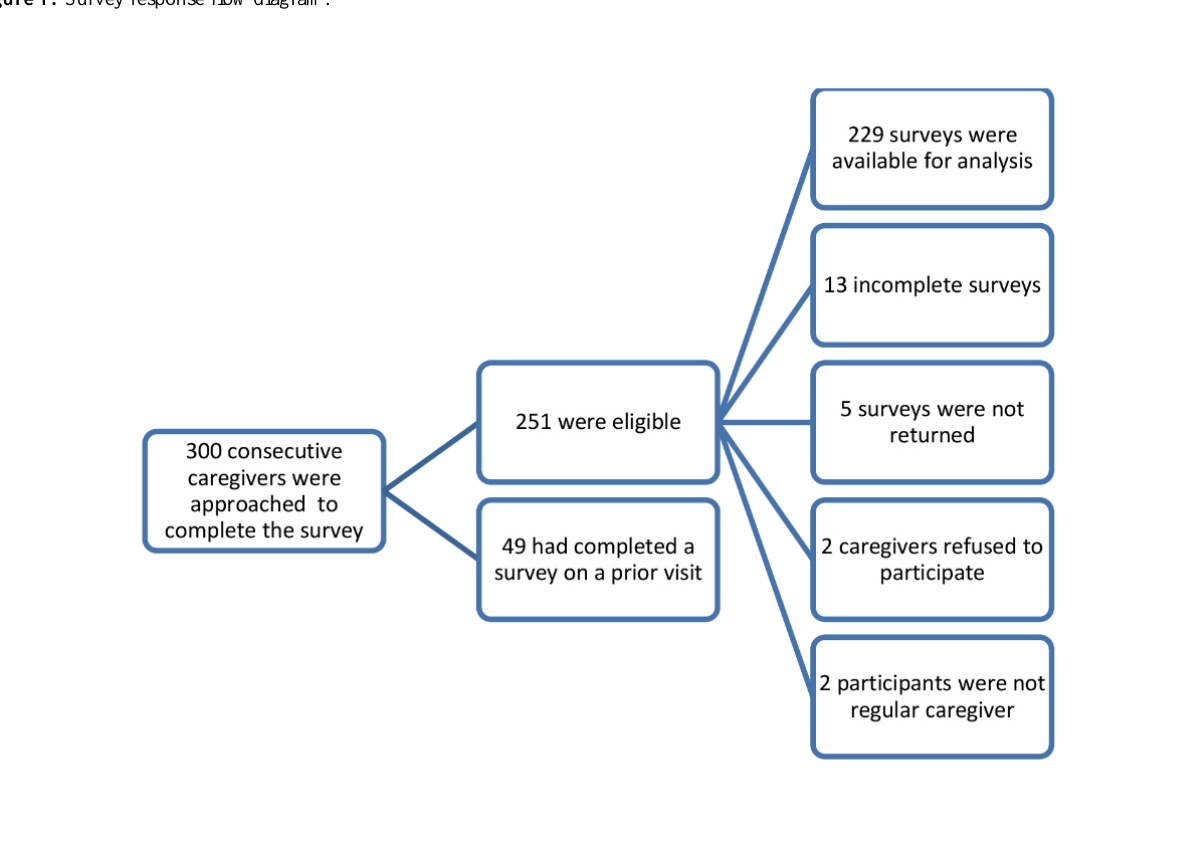
Figure 1. Survey response flow